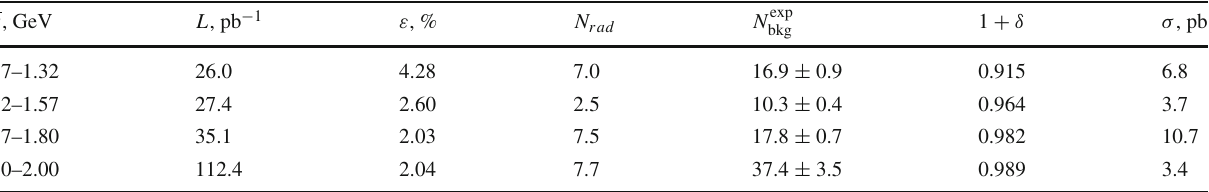
√ s ), integrated luminosity ( L ), detection Table 3 The energy range ( tive correction (1 + δ ), 90% CL upper limit on the Born cross efficiency ( ε ), 90% CL upper limit on number of events of radiative processes ( N rad ), number of expected background events ( N exp ), radia- bkg